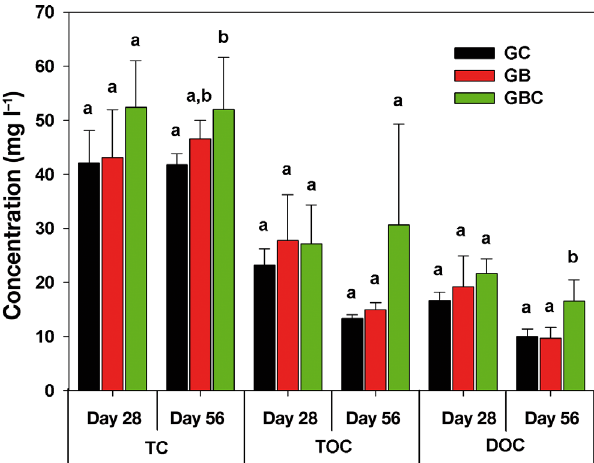
Fig. 7. Variations in total carbon (TC), total organic carbon (TOC), and dissolved organic carbon (DOC) in different treatment groups (see Table 1) on Days 28 and 56. Different lowercase letters indicate significant difference among groups at the same sampling time (ANOVA, p < 0.05). Data are mean ±